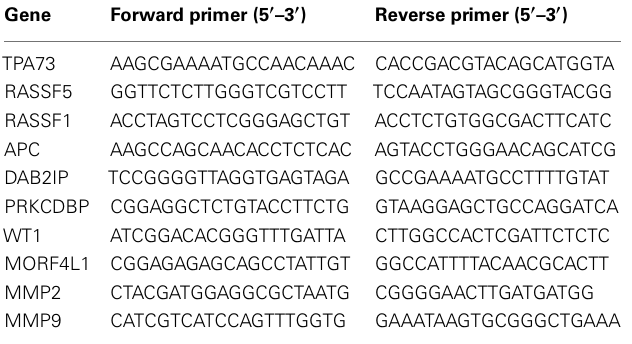
Table 2 | Primer sequences used in OneStep qMethyl kit.